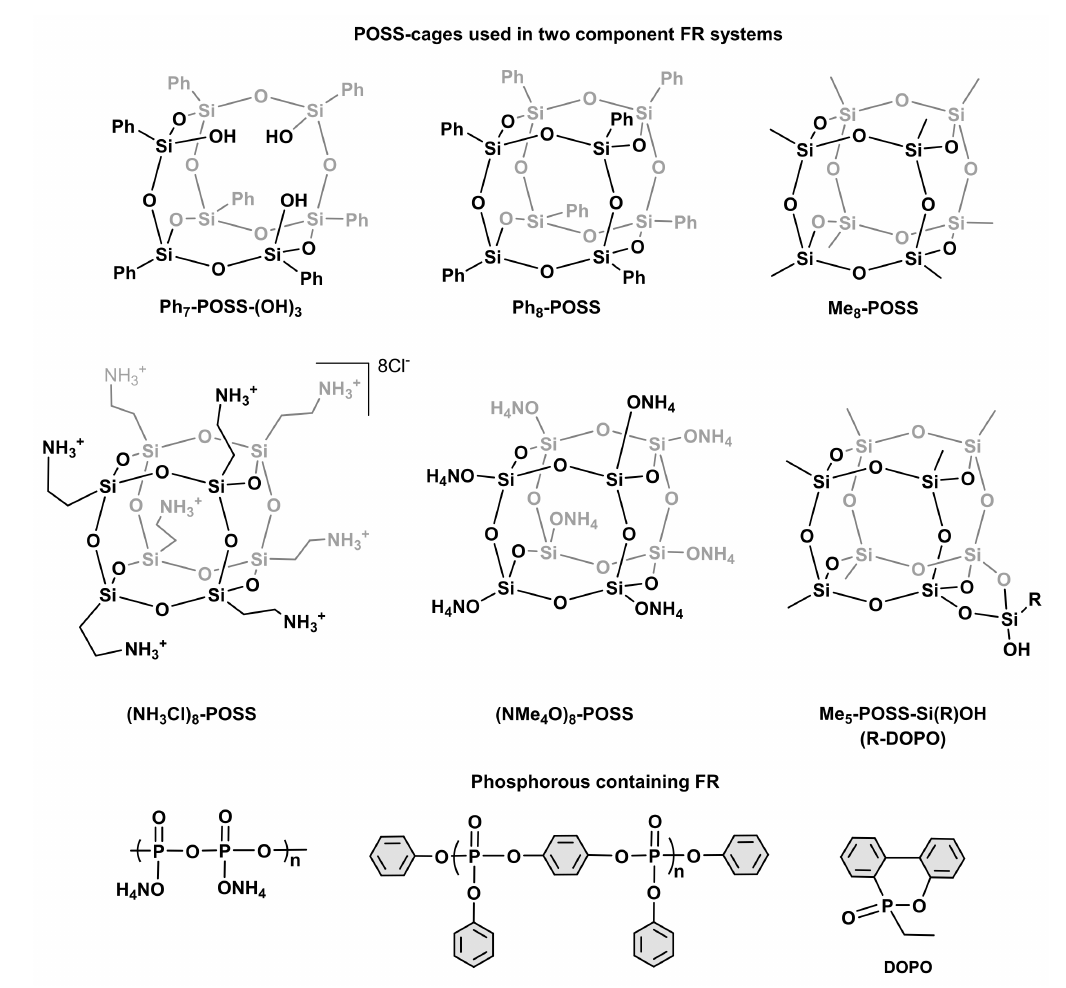
Figure 8. Examples of two-component FR systems based on POSS cages and classical P-containing flame